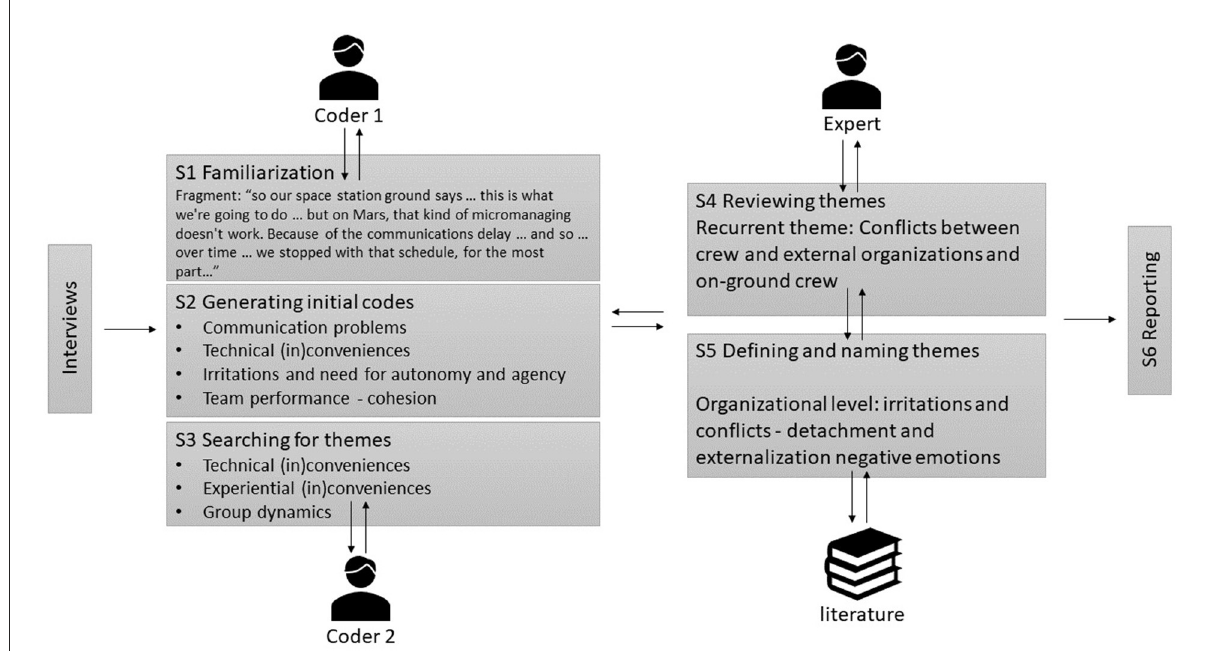
FIGURE1 Illustration of the applied methodology of Braun and Clarke (2006) with a triangulation method (Carter et al., 2014). The content is labeled in initial bottom-up driven codes, independent from theoretical concepts or models by two coders. Then these codes are discussed to create more generalizing themes. Then the themes are cross-checked with the literature and an expert, having extensive experience with the topic to generalize a final coding scheme before reporting